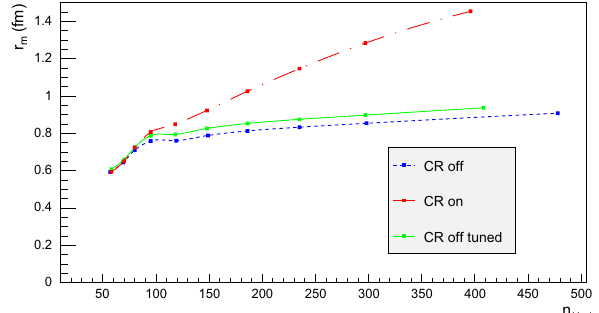
Fig. 25 Median radii as a function of multiplicity for 13 TeV pp col- lisions. The red curve corresponds to the approach with colour recon- nection, while the blue and green curves represent the model without colour reconnection and a tuned model without colour reconnection, respectively